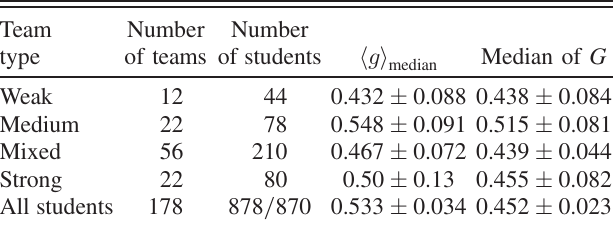
TABLE II. Median normalized gains for different team types and for all